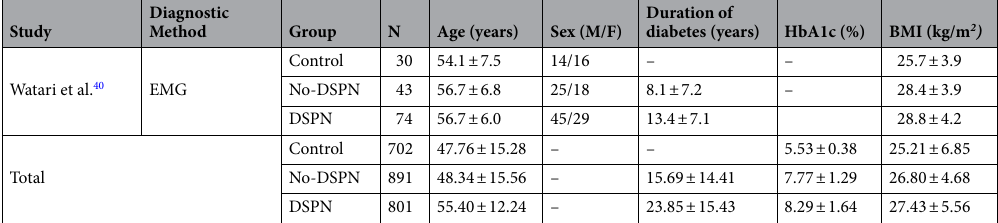
Table 1. Characteristics of included studies 19–40 .